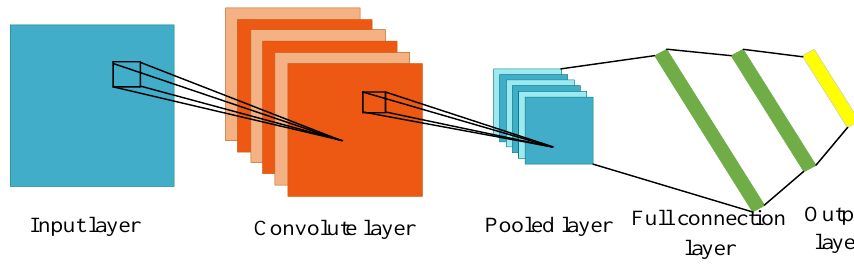
Figure 1. Basic structure of CNN.